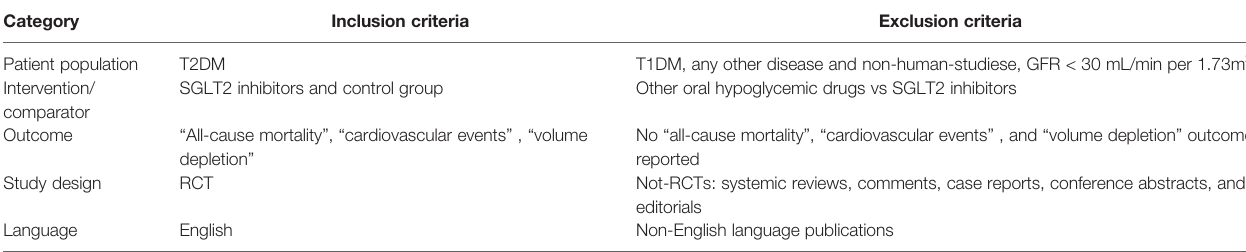
TABLE 1 | Inclusion and exclusion